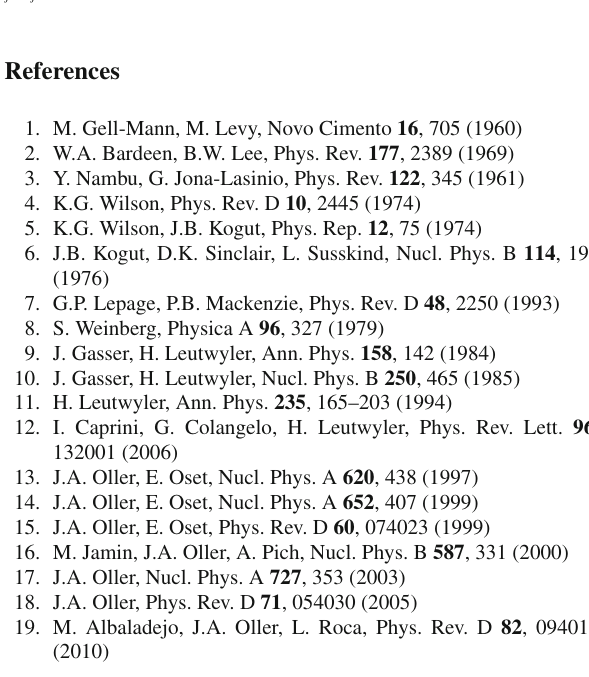
(cid:15) (cid:6) a j (dot-dashed line) with j